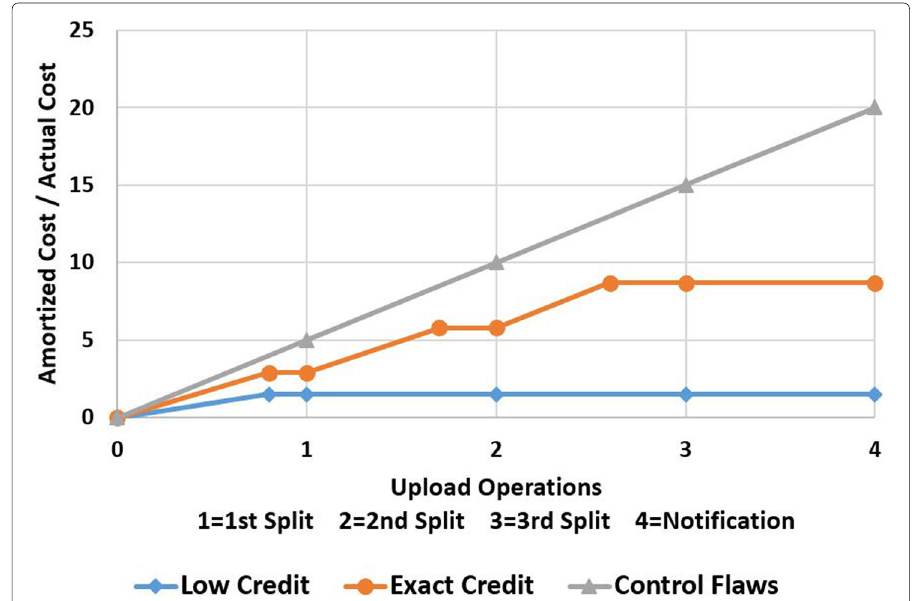
Fig. 7 Traditional approach vs proposed approach and breach detection